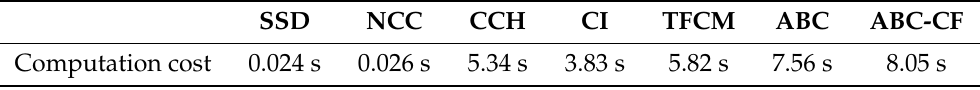
Table 2. Computation costs for seven